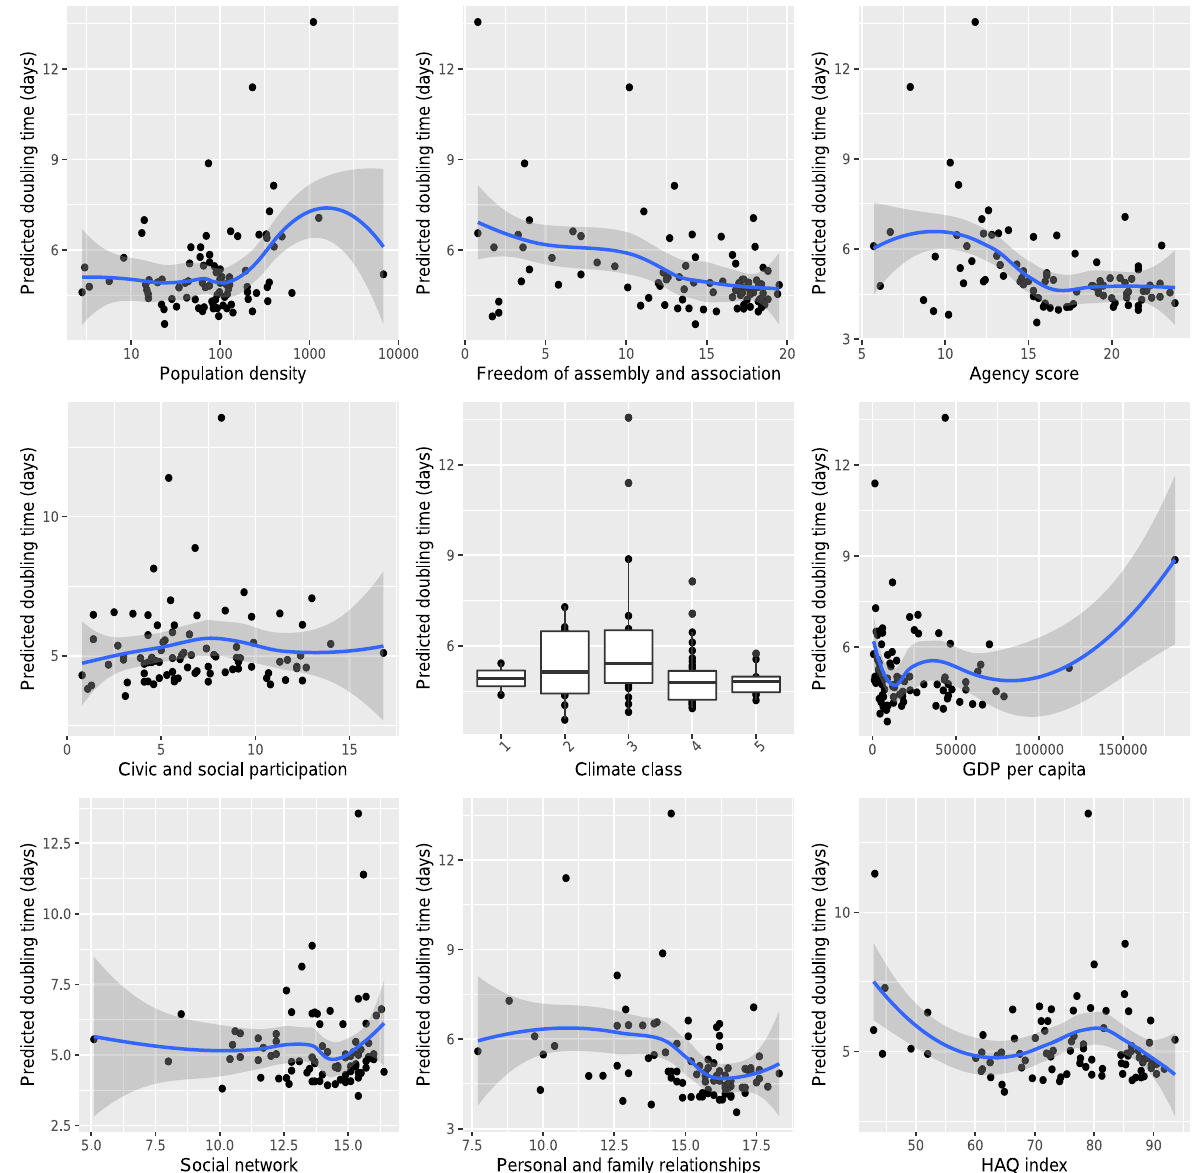
Fig. 2 Variable dependence plot of different covariates. Each predicted point is an individual observation, dependent on the full combination of all covariates (Ehrlinger,